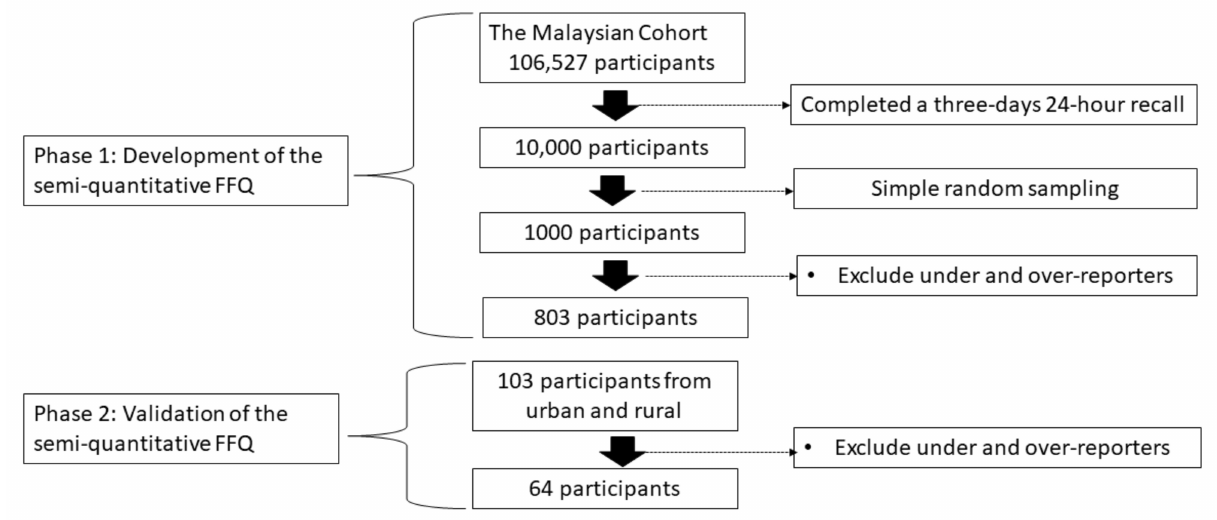
Figure 1. Flowchart on sample selection. FFQ denotes as Food Frequency